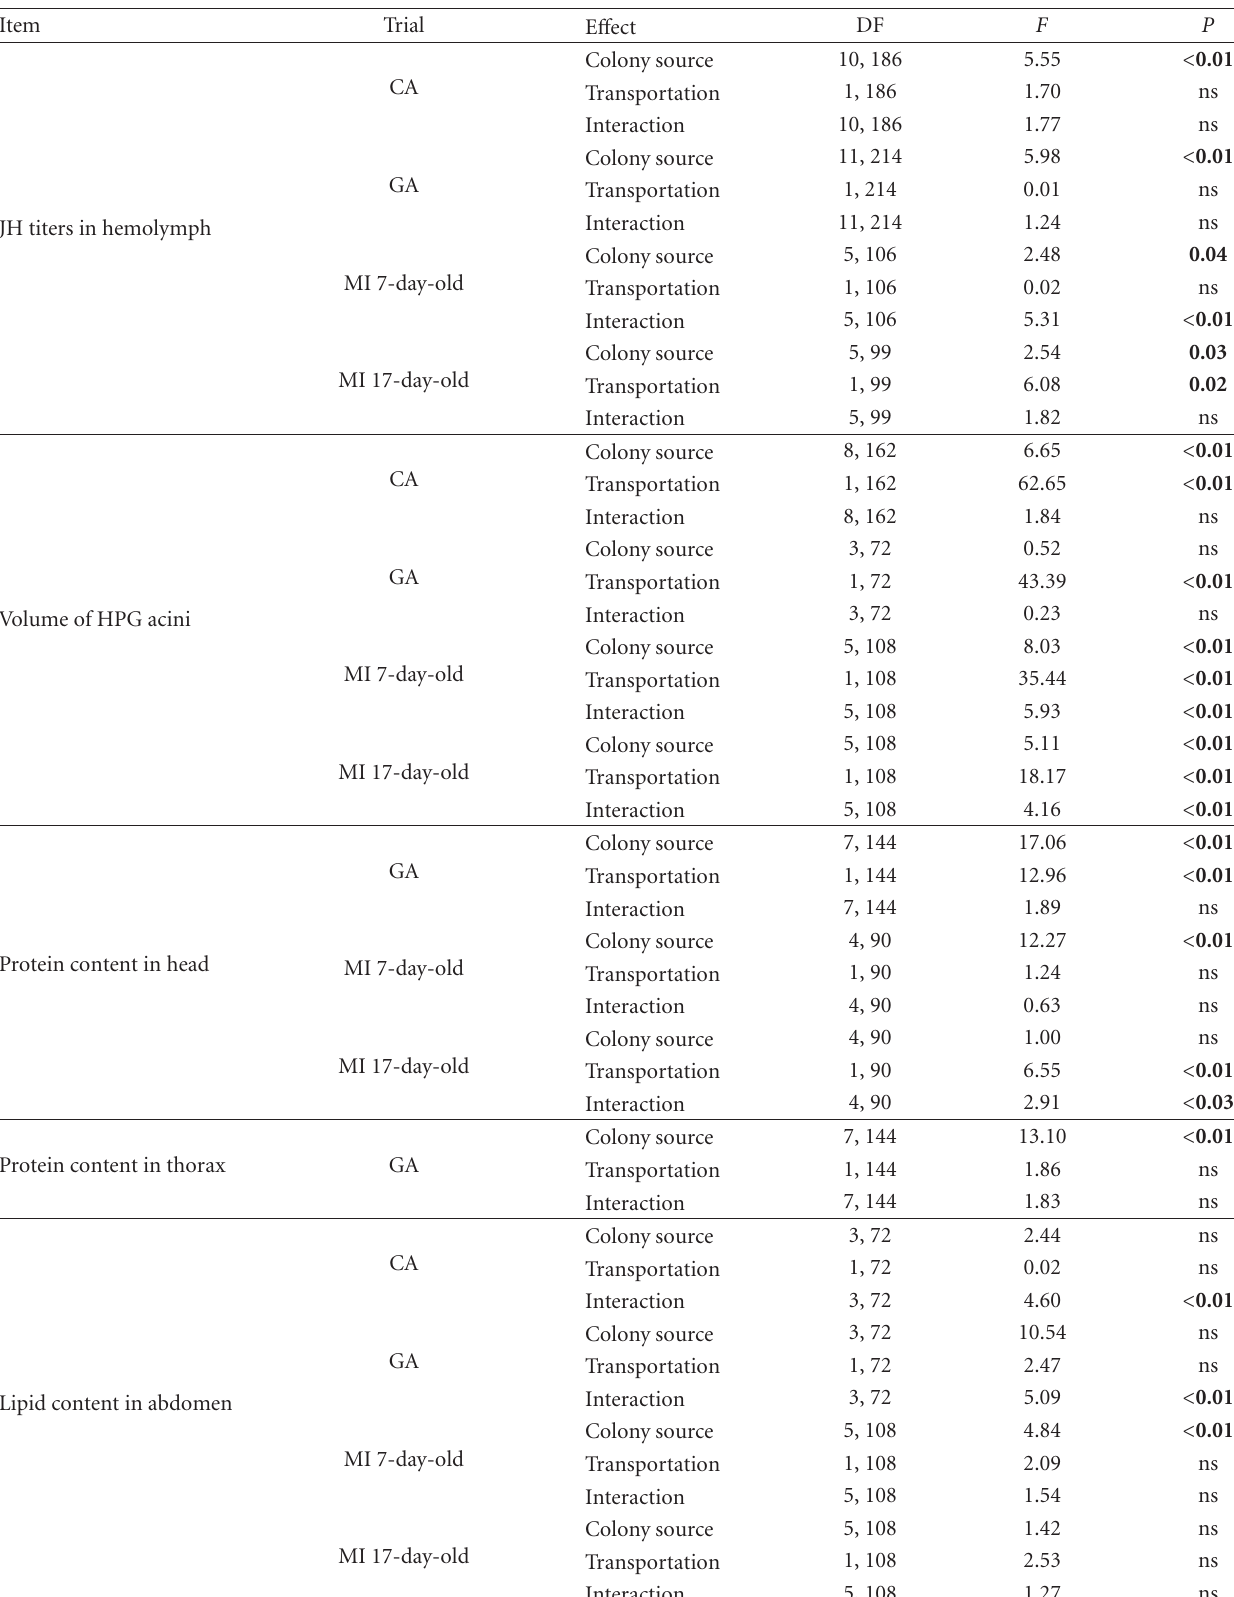
Table 1: F and P values from analysis of variance (ANOVA) conducted for each trial and each parameter, with “ns” denoting nonsignificant ( P > 0 . 05). JH titers were transformed (log(JH + 1)) before ANOVA. “Colony source” refers to the di ff erences due to genetic background of source colonies, “transportation” refers to the di ff erence between transported and stationary colonies, and interaction refers to the e ff ect of two (genetics X transportation status). Workers in CA were 6-7 days old, in GA were 8 days old, and those in MI were either 7 or 17 days